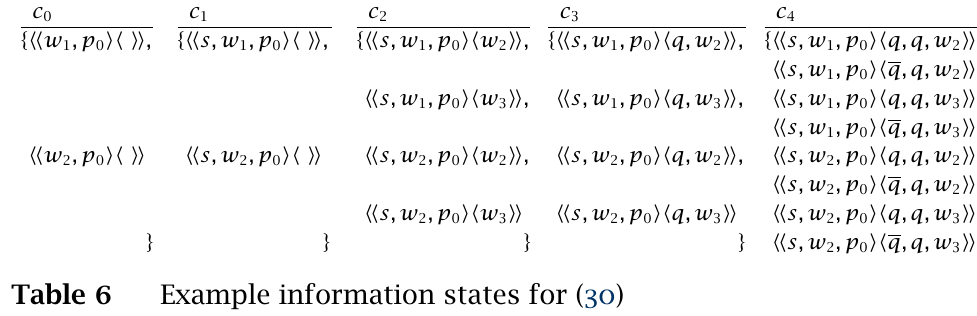
Example information states for ( 30